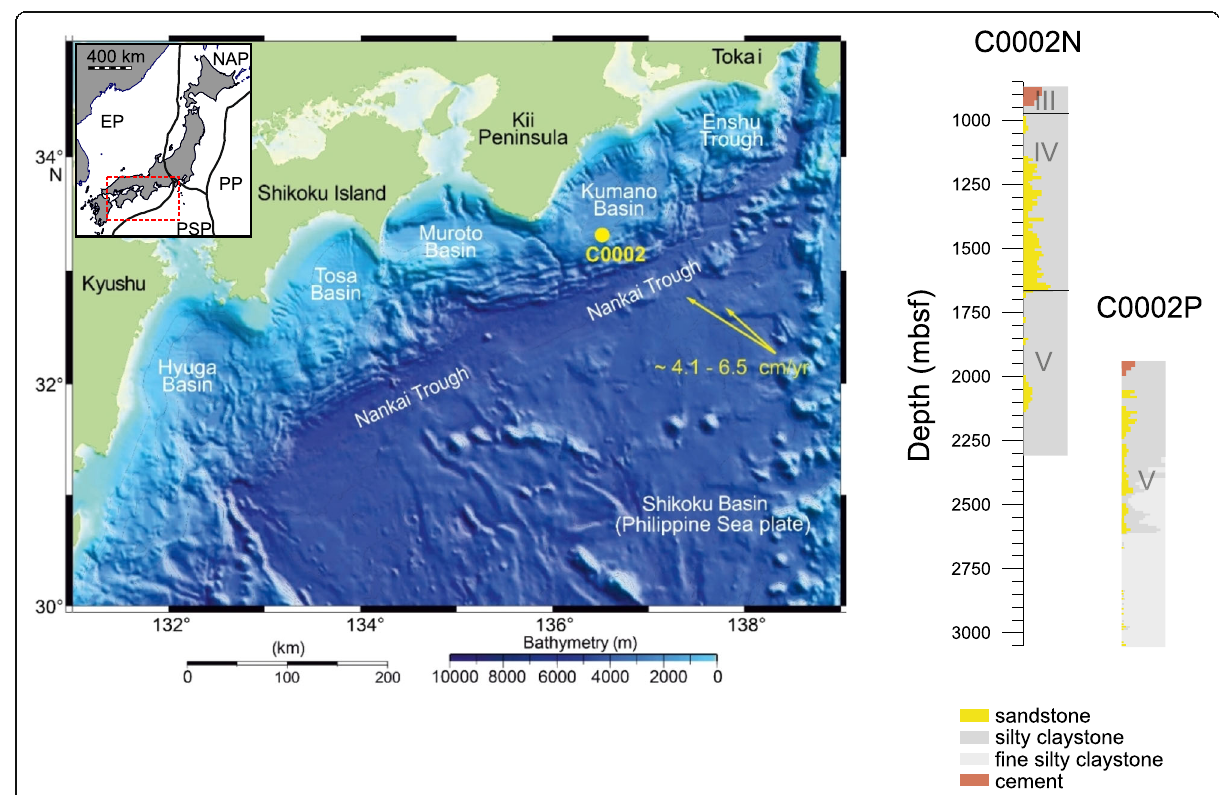
Fig. 1 left: Map showing the Nankai Trough area (modified from Screaton et al. 2009 and Hammerschmidt et al., 2014). Subduction of the Philippine Sea plate occurs at a rate of 4.1 to 6.5 cm/yr. Site C0002 is situated at the southern rim of the Kumano forearc basin, which is located between the Muroto Basin in the southwest and the Enshu Trough in the northeast. The regional tectonic setting is displayed in the inset (EP= Eurasian Plate, NAP = North American Plate, PP= Pacific Plate, PSP = Pacific Sea Plate). Right: Lithologic profiles and major lithologic unit boundaries III-V from C0002N and C0002P cuttings, modified from Expedition 348 Scientists and Scientific Participants,